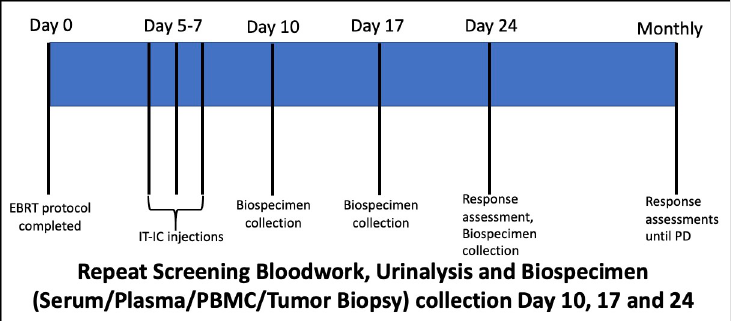
Fig 1. Protocol schema for tumor-bearing companion dogs receiving external beam radiation therapy in combination with intratumoral hu14.18-IL2